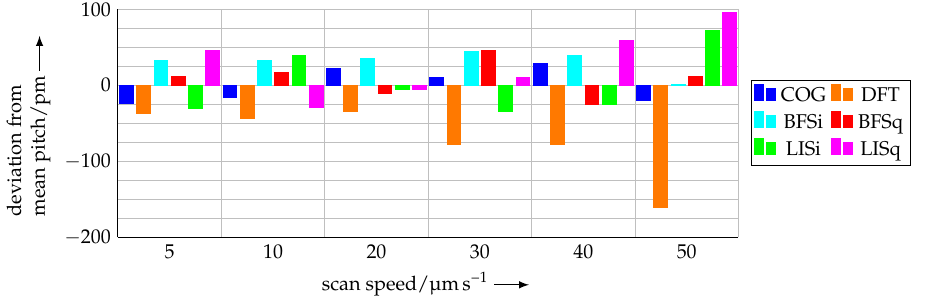
Figure 15. Deviations of the different analysis methods from the mean pitch for the according scan